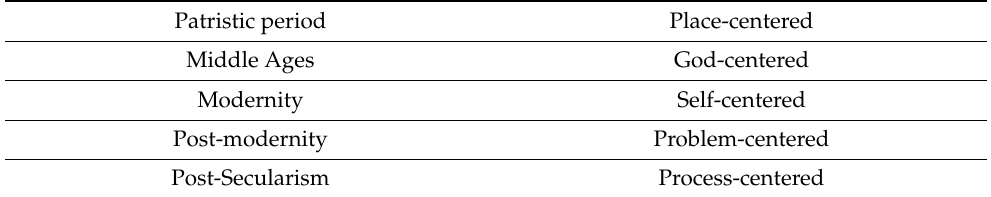
Table 2. Main Themes of Different Theologies of